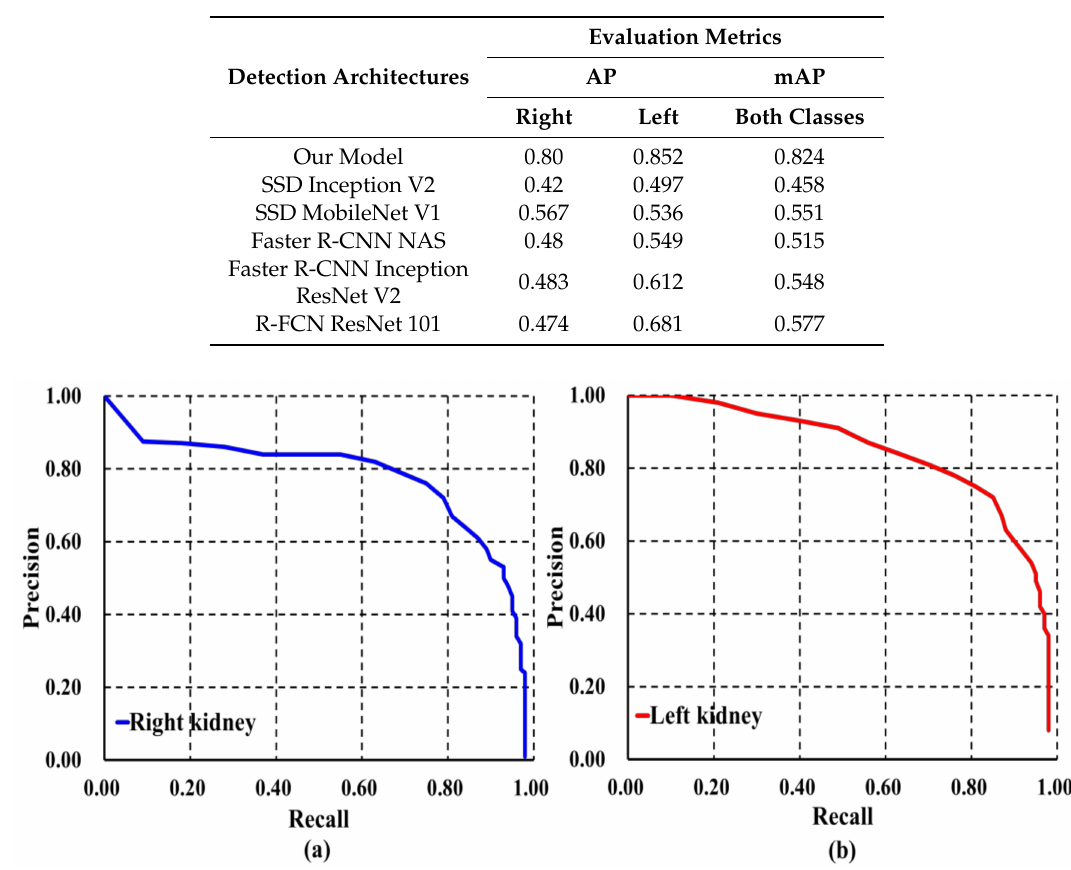
Table 5. AP and mAP comparison with other architectures on subject-wise testing.